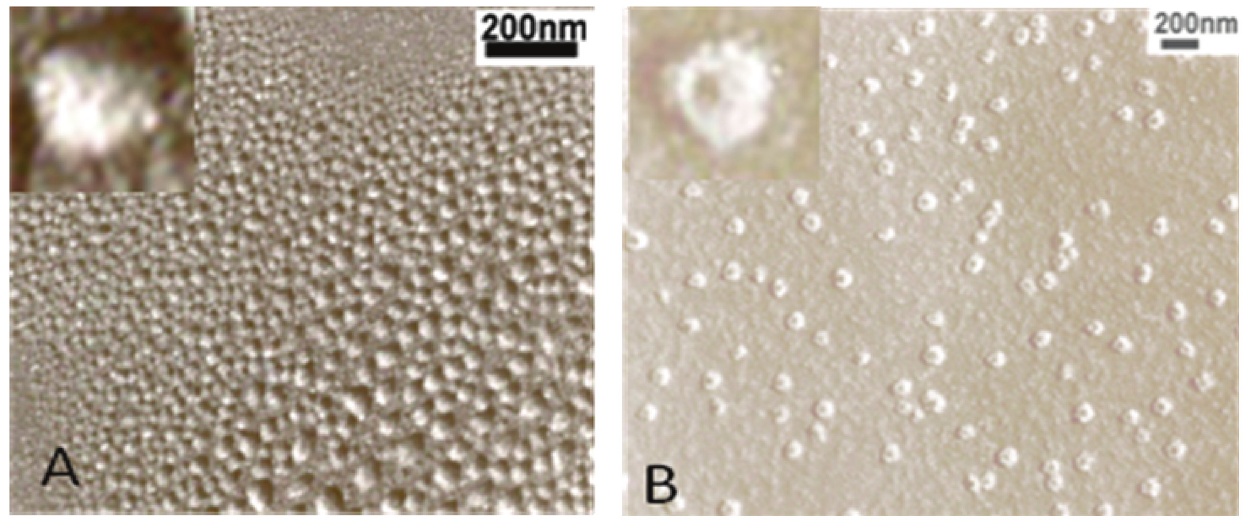
Figure 6. TEM measurements of (A) calf thymus and (B) plasmid DNA air dried from 95% DMF.